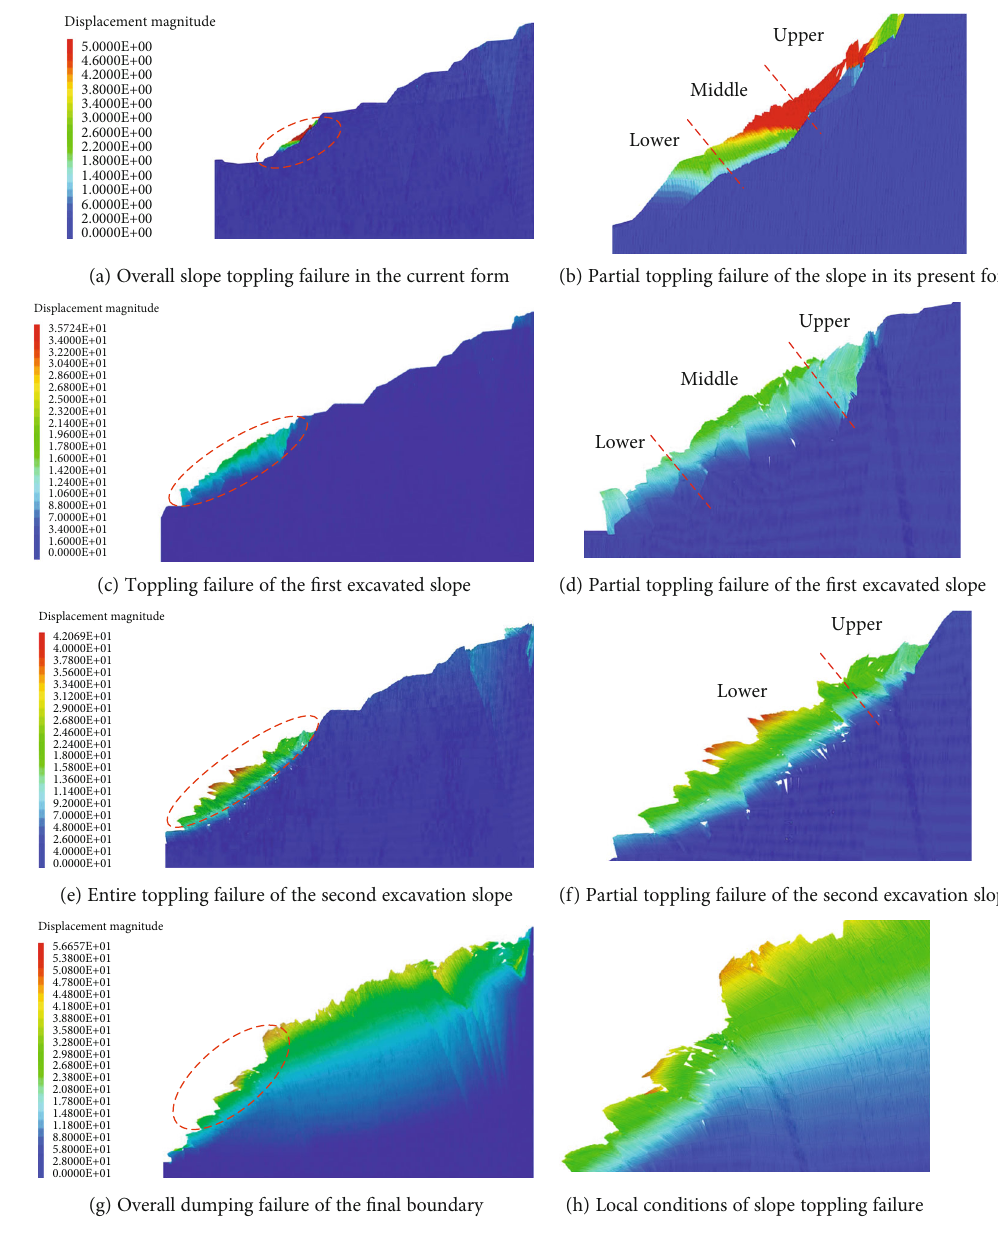
Figure 7: Slope collapse under di ff erent excavation